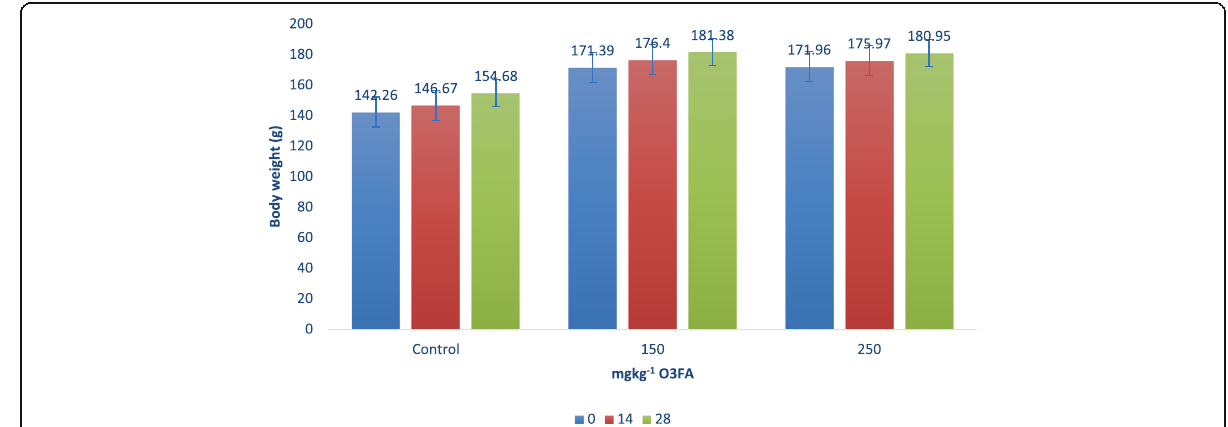
Fig. 1 Effect of O3FAs on body weight (g) in male